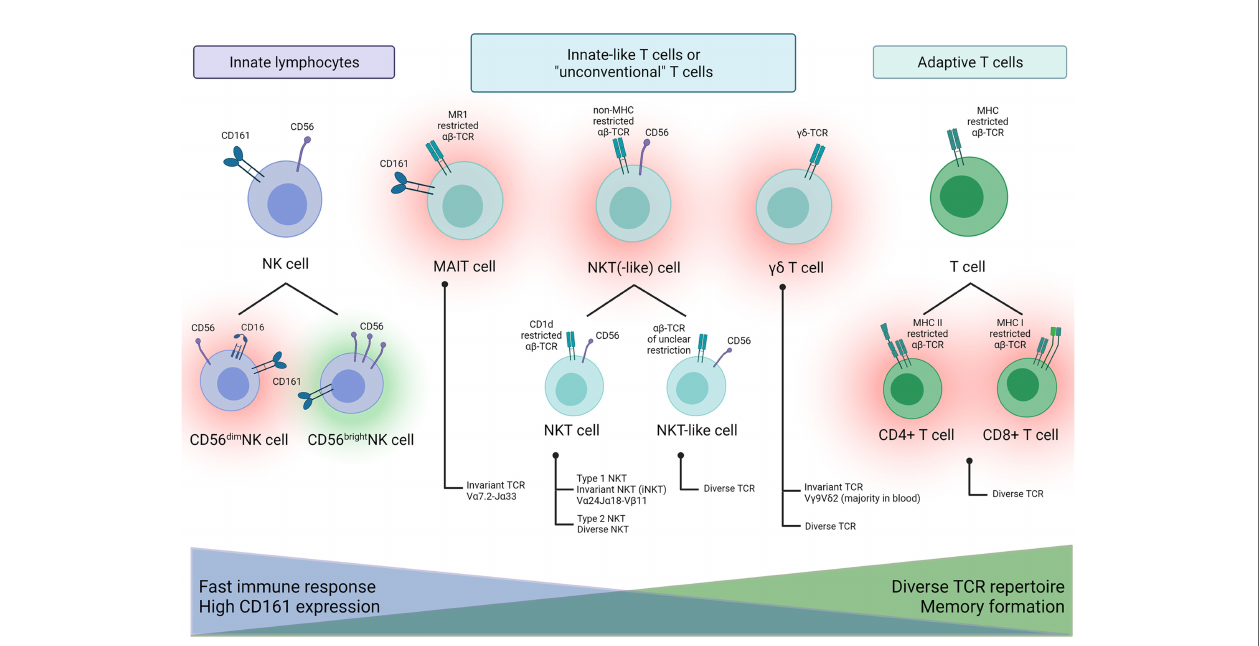
FIGURE 2 | Schematic overview of NK and innate-like T cell populations characterized in this study and their possible proin fl ammatory (red halo) or bene fi cial (green halo) role in